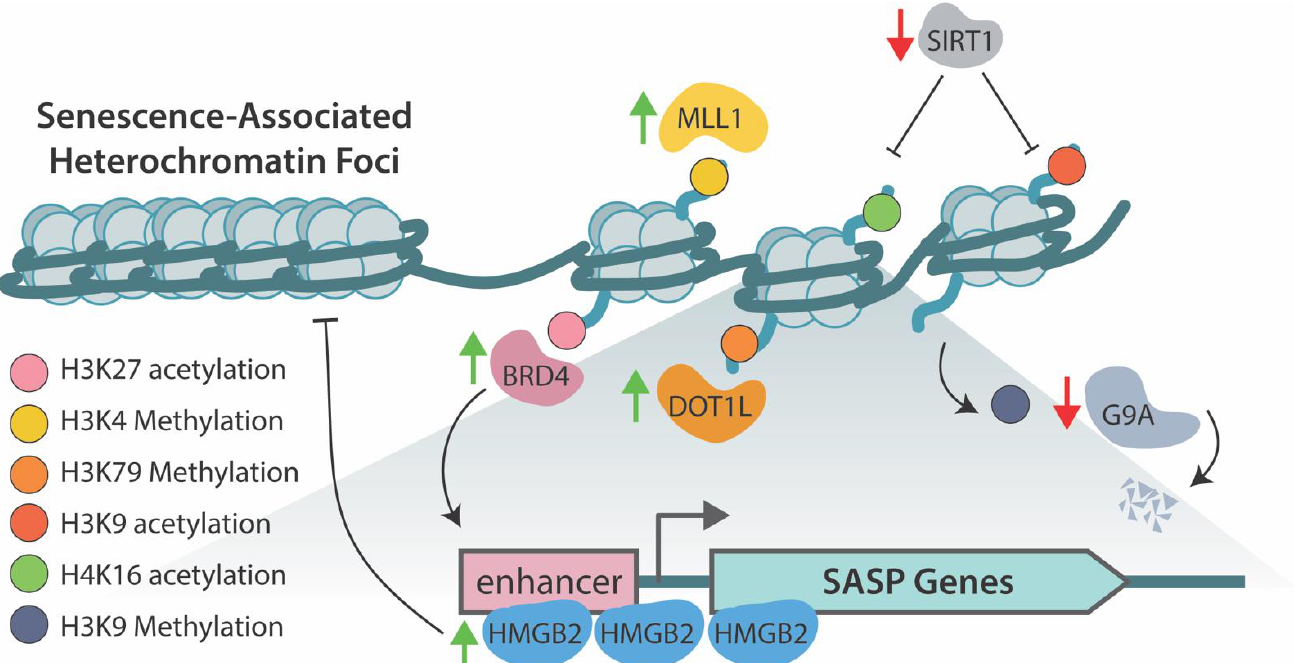
Figure 2. An overview of the histone acetylation/methylation marks and proteins that regulate genes involved in the senescence-associated secretory phenotype (SASP). High-mobility-group protein B2 (HMGB2) binds loci of key SASP genes preventing their incorporation into the SAHF during senescence allowing for their transcription [120]. Mixed-lineage leukemia 1 (MLL1) methylates H3 at Lys-4 to promote transcription of SASP genes [122]. Disruptor of telomeric silencing 1-like (DOT1L) mediates methylation of H3 at Lys-79 driving transcription of potent inflammatory cytokine and SASP factor IL1A [123]. Bromodomain-containing protein 4 (BRD4) mediated acetylation of H3 at Lys-27 is necessary to drive transcription of SASP factors during senescence [121]. G9a and G9a-like proteins, which deposit repressive methylation on H3 at Lys-9, prevent transcription of SASP genes in proliferating cells [124]. In response to DNA damage, these proteins are degraded, allowing for ac- tive transcription of IL-6 and IL-8. NAD-dependent deacetylase sirtuin-1 (SIRT-1) negatively regu- lates SASP expression through deacetylation of H4 Lys-16 and H3 Lys-9 in normal proliferating cells. Senescence induction decreases expression of SIRT-1, allowing for acetylation and expression of key SASP genes [126].